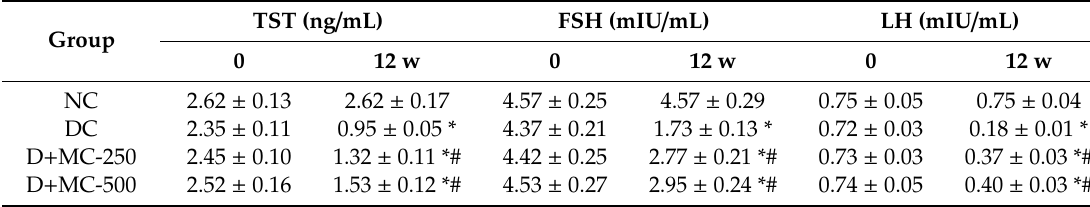
Table 3. E ff ect of MC on blood levels of testosterone, follicle-stimulating hormone (FSH), and luteinizing hormone (LH) of STZ-induced diabetic male rats. TST (ng / mL) Group